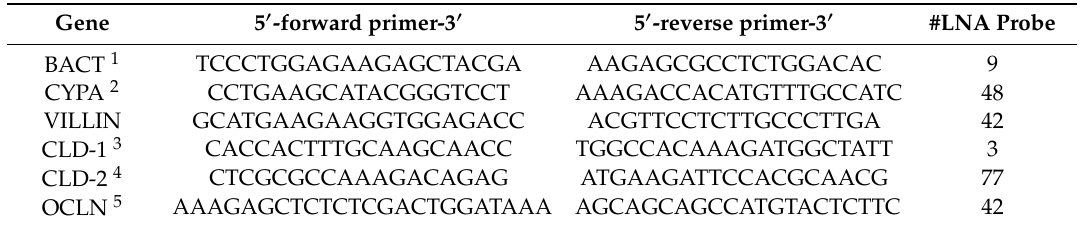
Table 1. LNA probe-based real-Time PCR